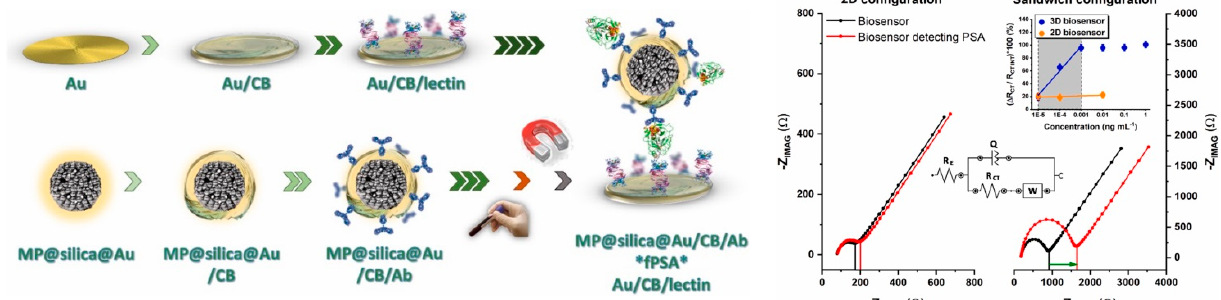
Figure 10. Sensitivity enhancement of electrochemical impedance spectroscopy-based PSA glycoprofiling using hybrid magnetic particles. ( Left image ) Modification of Au electrode (upper row) using carboxybetaine aryldiazonium derivative (CB) and lectin (SNA-I). In the first step, carboxybetaine-bearing SAM layer was formed using cyclic voltammetry, and